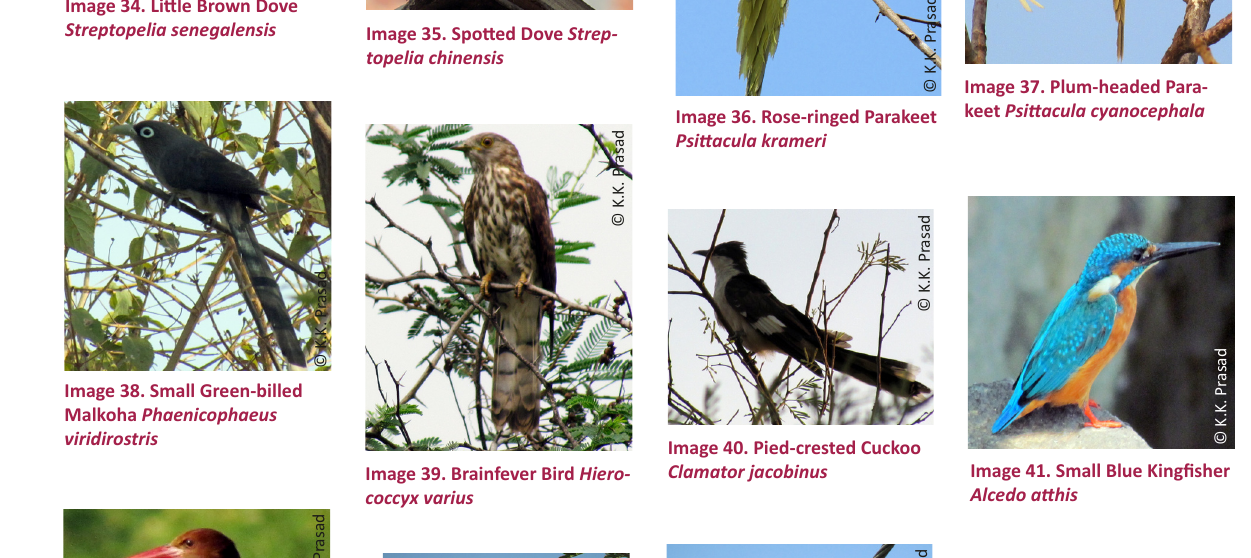
topelia chinensis